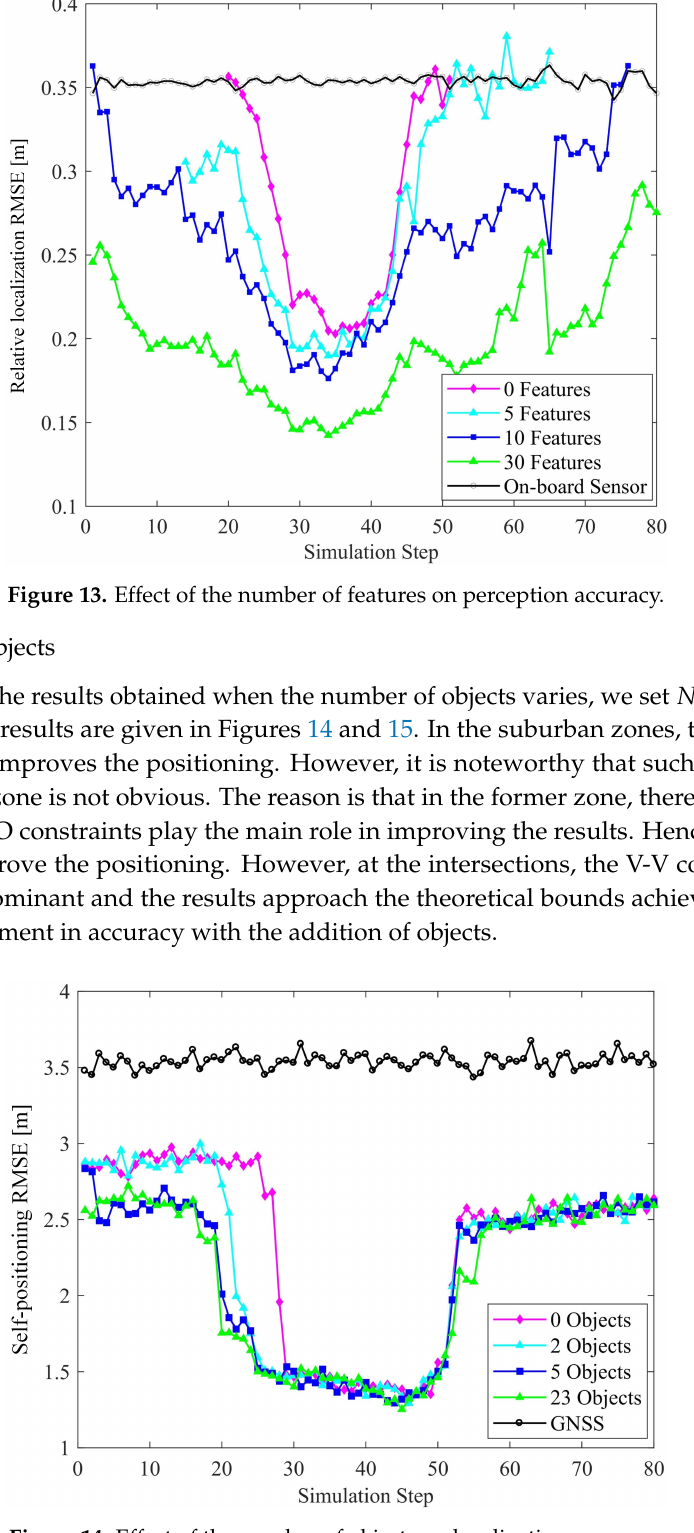
Figure 14. Effect of the number of objects on localization